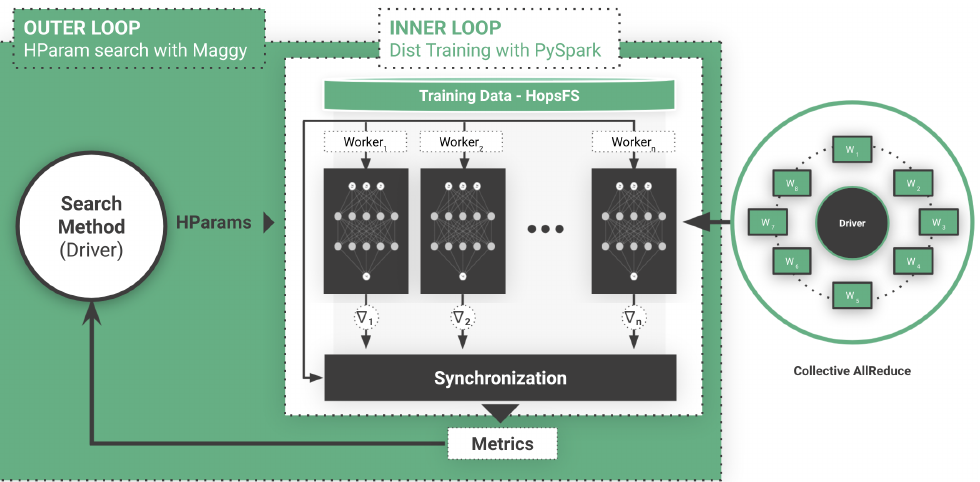
Figure 8. Scaling out distributed training of ML and